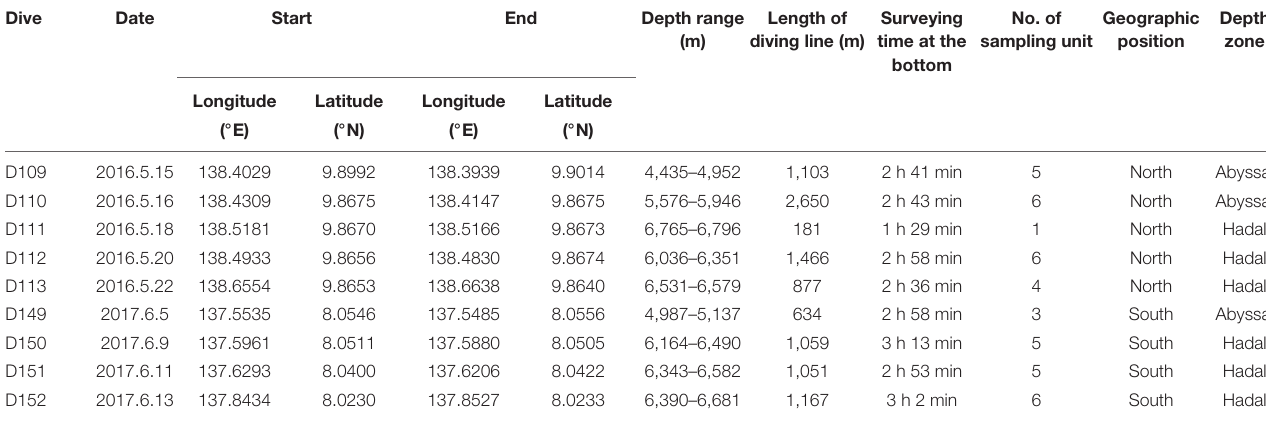
TABLE 1 | Information of nine “ JIAOLONG ” dives conducted during the two COMRA cruises.